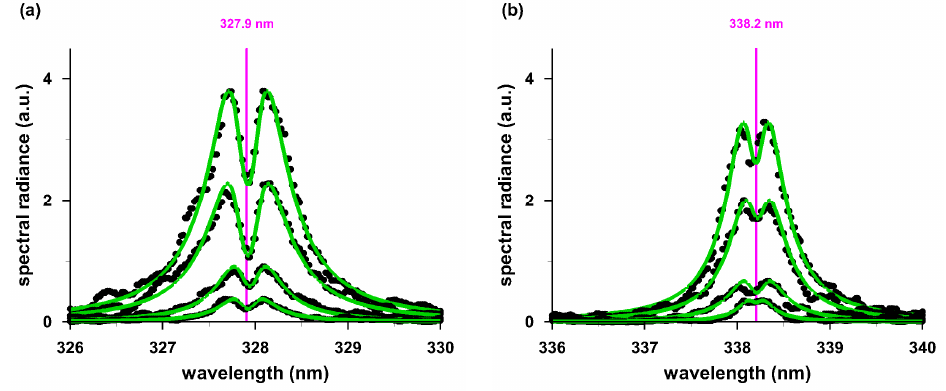
Figure 4. Ag I ( a ) 327.9 nm and ( b ) 38.2 nm lines, 532-nm excitation, fluences of 13.5, 11.5, 8, and 6 J/cm 2 .